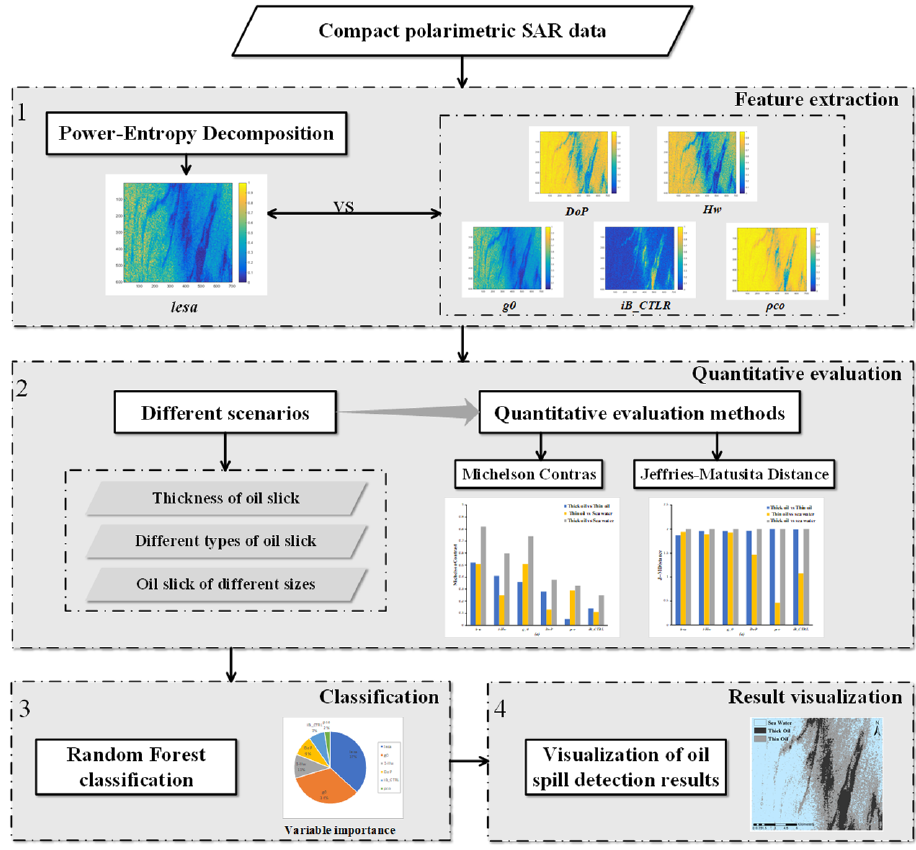
Figure 1. Oil spill detection flowchart.